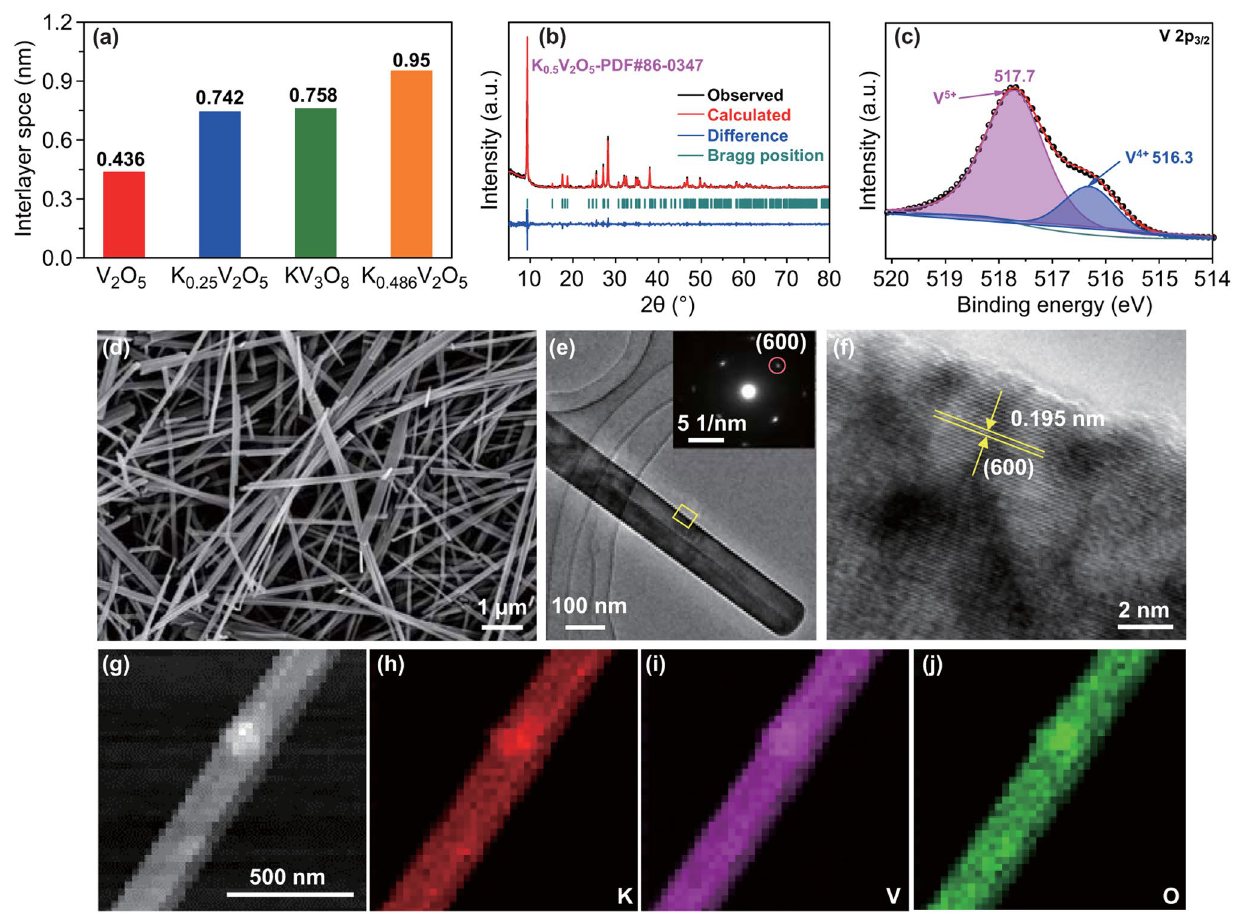
Fig. 2 a Comparison of interlayer space of various vanadium compounds. b XRD pattern of KVO and the corresponding Rietveld refinement results. c XPS spectrum of V 2p 3/2 . d SEM image, e TEM image (inset: SAED pattern), and f HRTEM image of KVO. g–j EDS